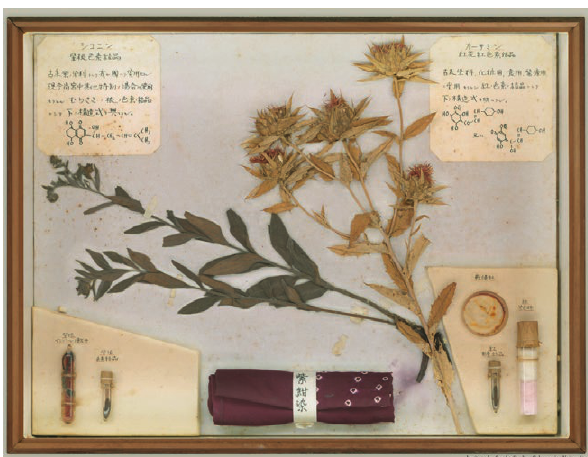
Figure 11. (Ku-5001). Research results specimen kept by Kuroda: Shikon and Carthamin. Crystals and structural formula of Shikonin, Carthamin and Murasaki, Benibana (dry), purple dyeing. Experiments Materials: Murasaki – Root of Murasaki including pigment. Shikonin Research: gromwell root (of species Lithospermum